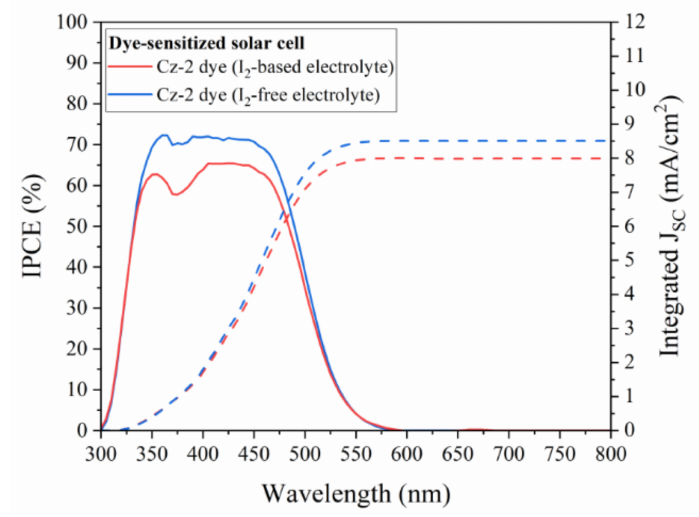
Figure 7. Incident photon-to-electron conversion efficiency (IPCE) curves of the solar cells that employed the working electrodes that were sensitized by the Cz-2 dye, using the I 2 -based or I 2 - free electrolyte.